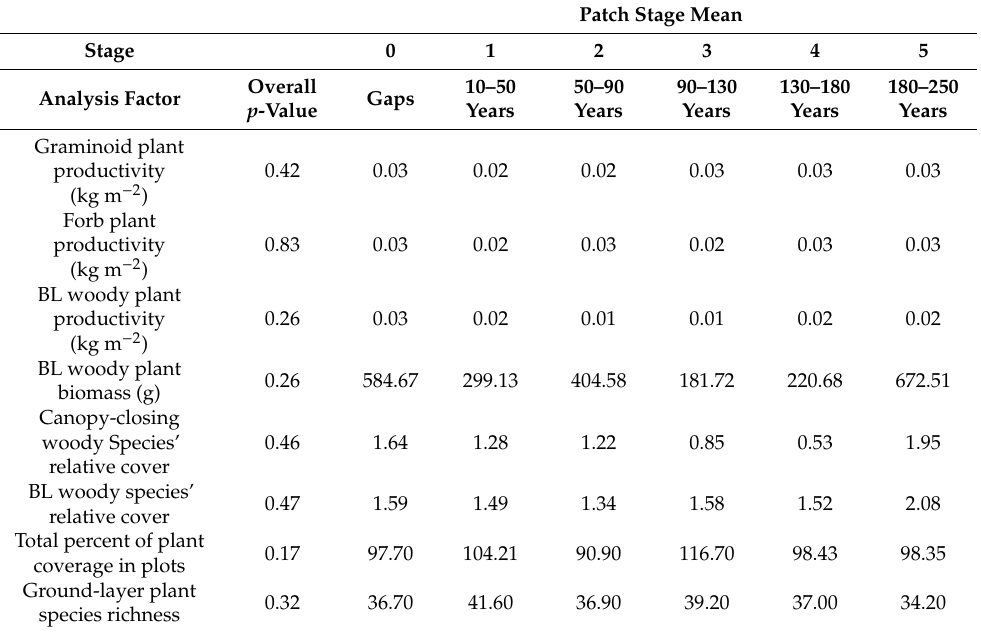
Table A4. Mean values of estimated plant productivity, broadleaf (BL) woody plant biomass, and ground-layer plant community relative cover attributes in each of the six patch stages and overall stage e ff ect p -value from PerMANOVA analyses ( p <